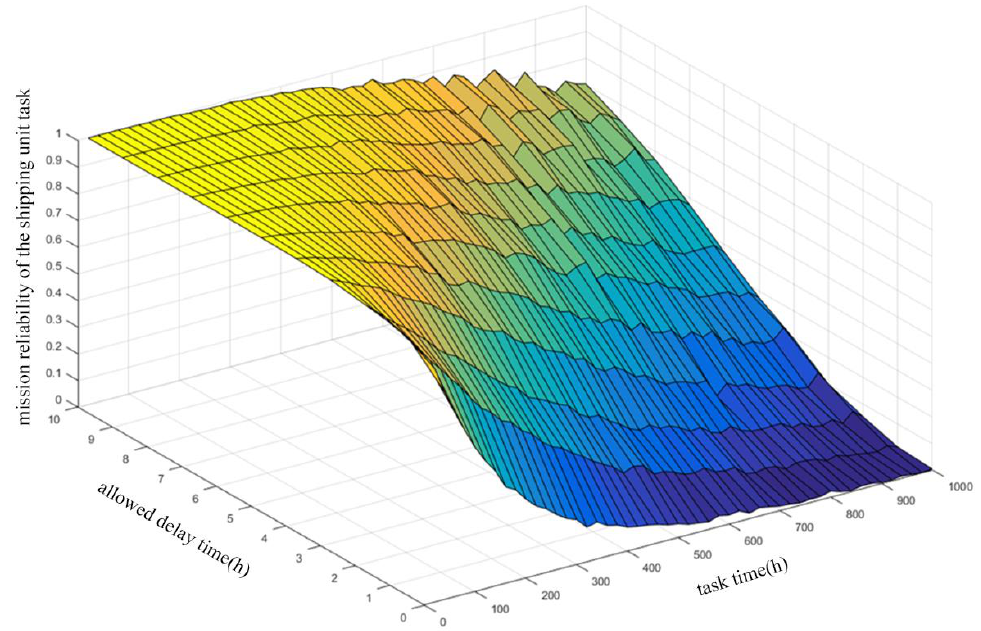
Figure 17. The mission reliability surface of the shipping unit task varies with the task parameters. For equipment reliability structure, the power system uses difference reliability struc- ture in the two unit